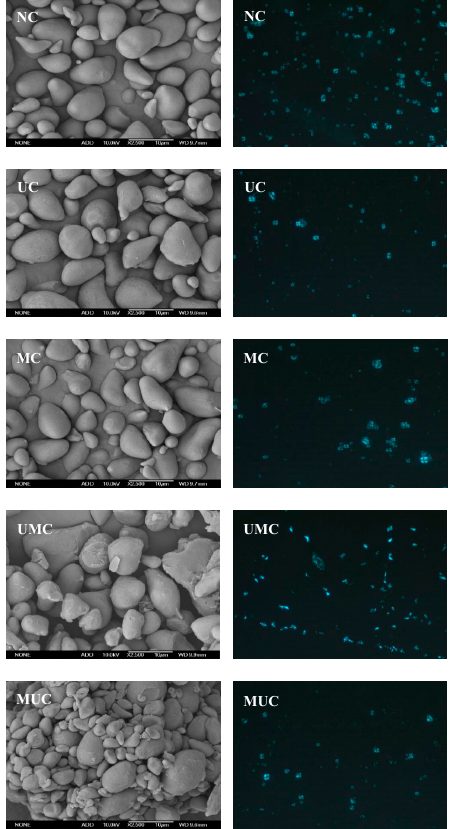
Figure 1. Scanning electron microscopy (2500 × ) ( left ) and polarized light microscopy (25 × ) ( right ) of native and modified chestnut starches. NC: native chestnut starch, UC: ultrasonic modified starch, MC: microwave modified starch, UMC: ultrasonic-microwave modified starch, MUC: microwave-ultrasonic modified